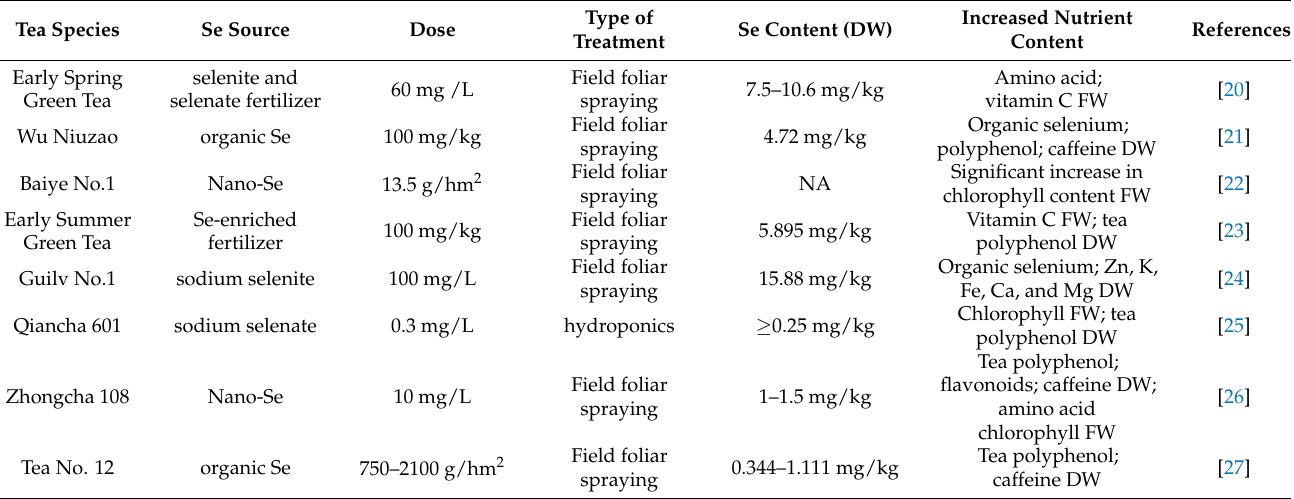
Table 1. Tea plant: different species, selenium treatment (Se source, dose, type of treatment), and total Se content and nutritional